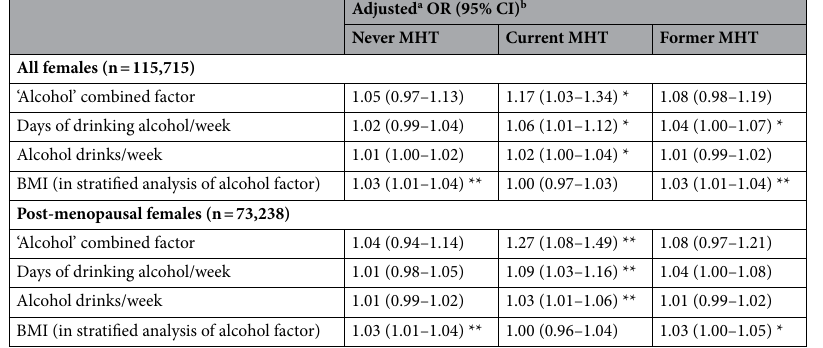
Table 2. Association between alcohol and breast cancer incidence, stratified by MHT use, with a focus on post-menopausal females to adequately reflect dependencies between MHT use and menopausal status. CI confidence interval. a Adjusted for age, Body Mass Index (BMI), self-reported health at baseline, the number of GP visits in the 2 years prior to baseline, self-reported participation in breast screening prior to baseline, private health insurance, remoteness of residence. * P < 0.05, ** P < 0.01. b OR = odds ratio (per 1 unit change in the continuous